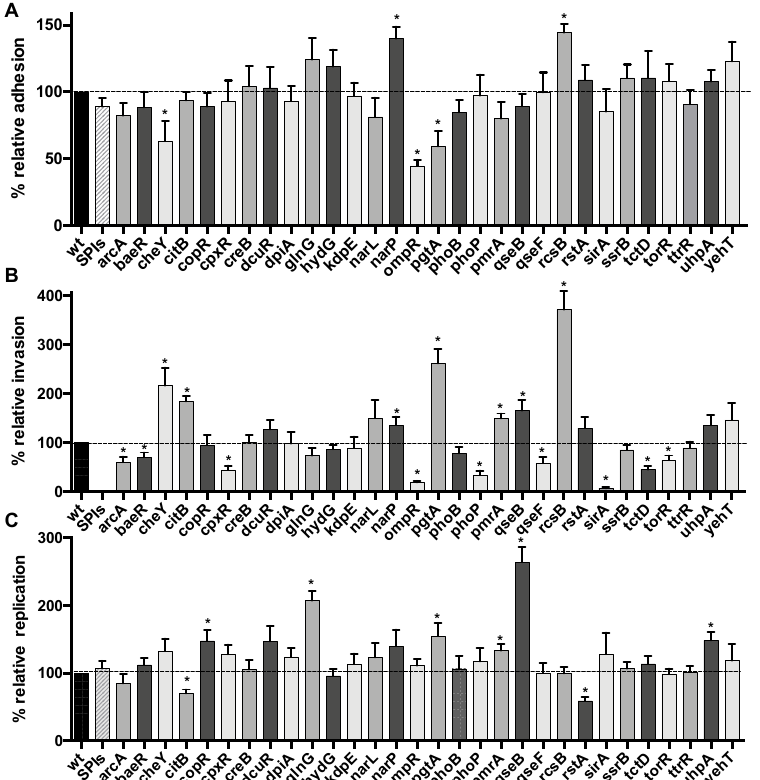
Figure 1. Effect of loss of TCS response regulators on interaction with human epithelial cells. INT-407 epithelial cells were infected with S . Typhi wild-type strain and the isogenic RR mutants, and the level of bacteria associated with cells was determined upon adherence (90 min) ( A ), invasion (180 min) ( B ), or after 18 h ( C ). All assays were conducted in triplicate and repeated independently at least three times. The results are expressed as the mean ± SEM of the replicate experiments. Significant differences (* p < 0.0001) in the levels recovered as compared to the wild-type were determined by the Student’s unpaired t -test. The dashed line corresponds to the wild-type level.